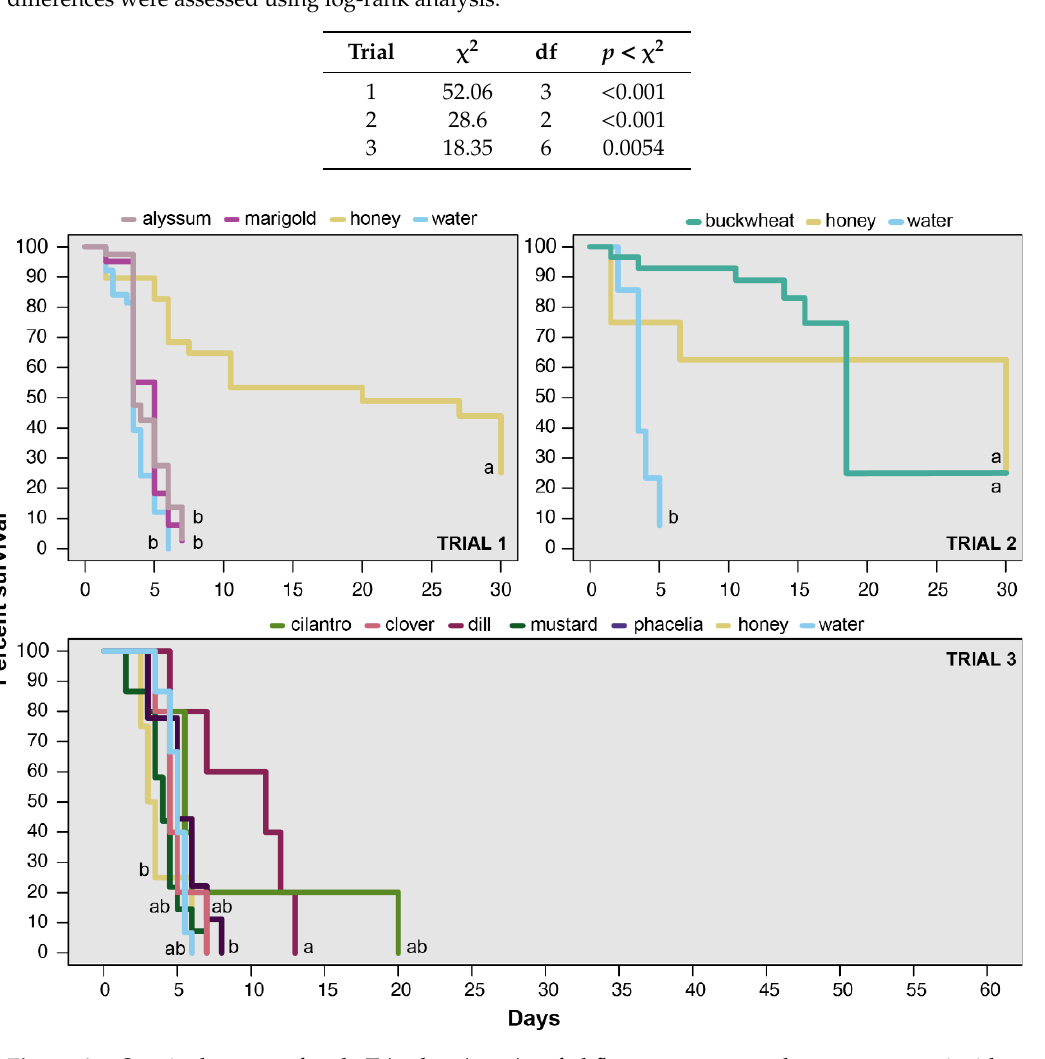
Table S1: Trissolcus japonicus floral resource data.